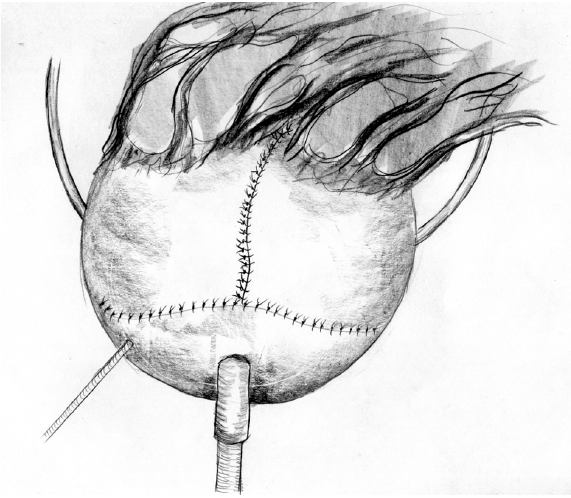
Figure 6 – Final aspect after placement of the balloon that was insufflated with 100 mL of physiological saline solution.